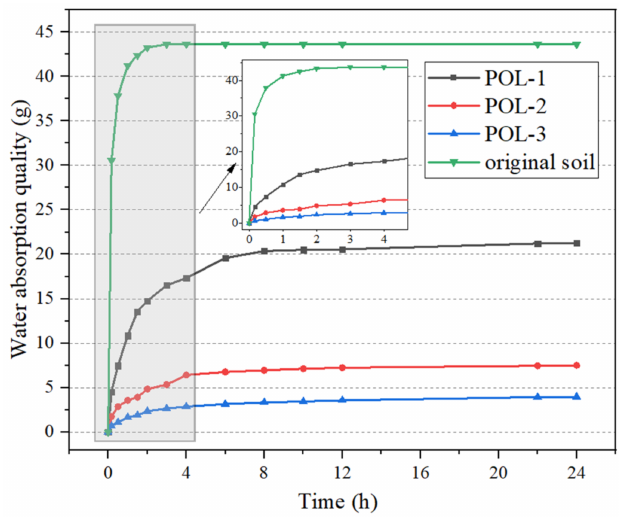
Figure 7. Group B capillary water absorption test